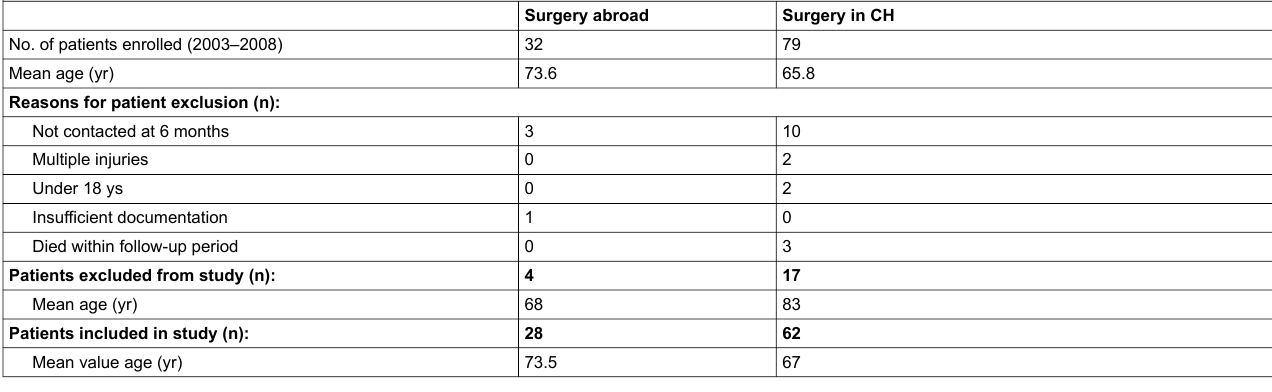
Table 2: Patient characteristics and place of surgical intervention.